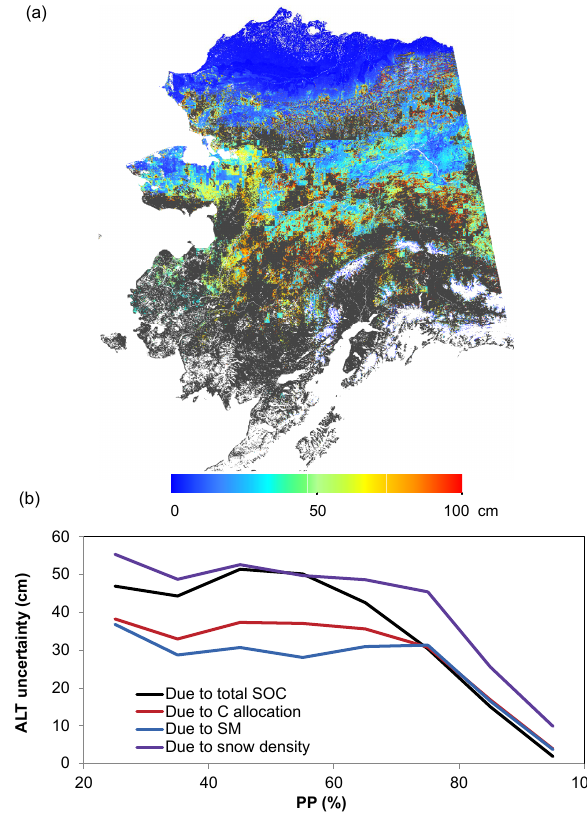
Figure 7. Model estimated ALT uncertainty associated with uncer- tainties in SOC fraction, SM, and snow cover properties: (a) spa- tial pattern of model-simulated ALT uncertainty due to uncertainty in the total SOC content; the areas without consistent near-surface ( < 300cm) permafrost from all sensitivity runs are shown as dark gray. (b) shows the distribution of model mean ALT uncertainties associated with uncertainties in total SOC content, soil carbon al- location, soil moisture, and snow density for different permafrost zones (Fig. 3b). The ALT uncertainties were calculated as the stan- dard deviation between the model baseline simulations and the sen- sitivity runs by adding uncertainties in the regional SOC map, soil moisture, and snow density data (Fig.